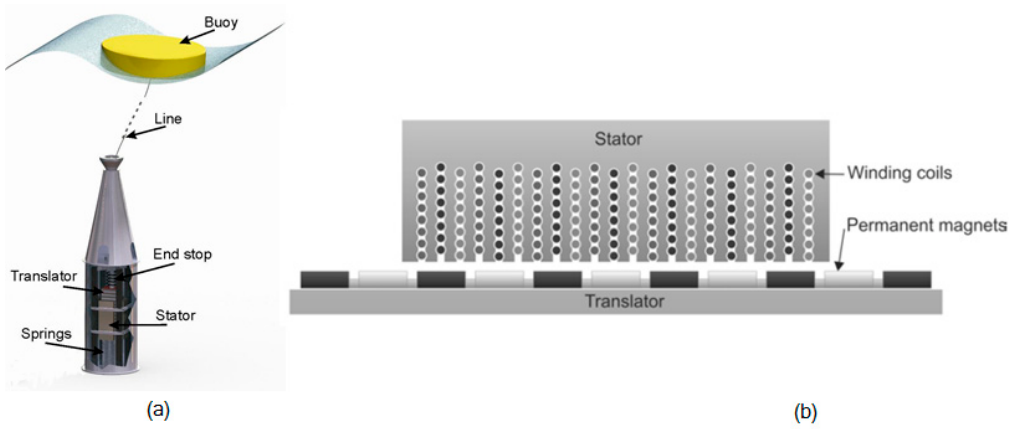
Figure 1. ( a ) Illustration of the wave energy converter (WEC) considered in this study; ( b ) sketch of the stator and translator of the linear generator (LG).